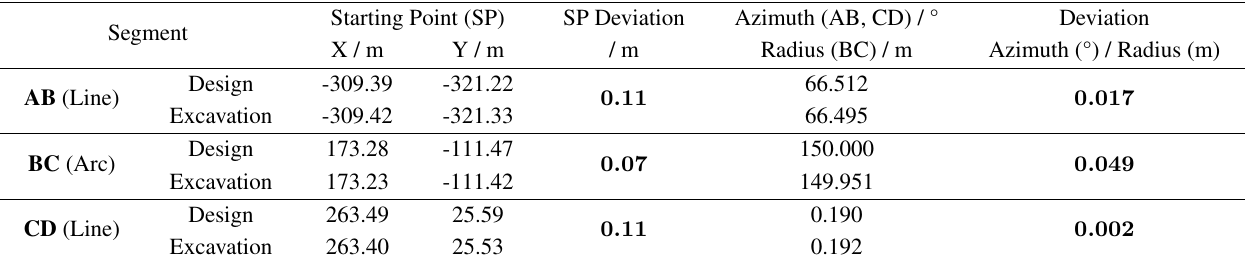
Table 2. Results of the segment-wise centerline deviation evaluation.